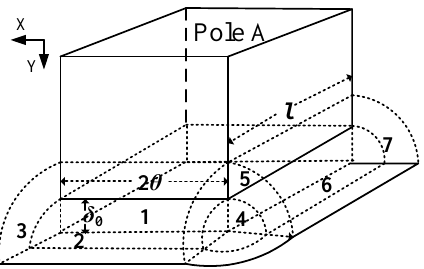
Figure 4. Region division of the edge flux.